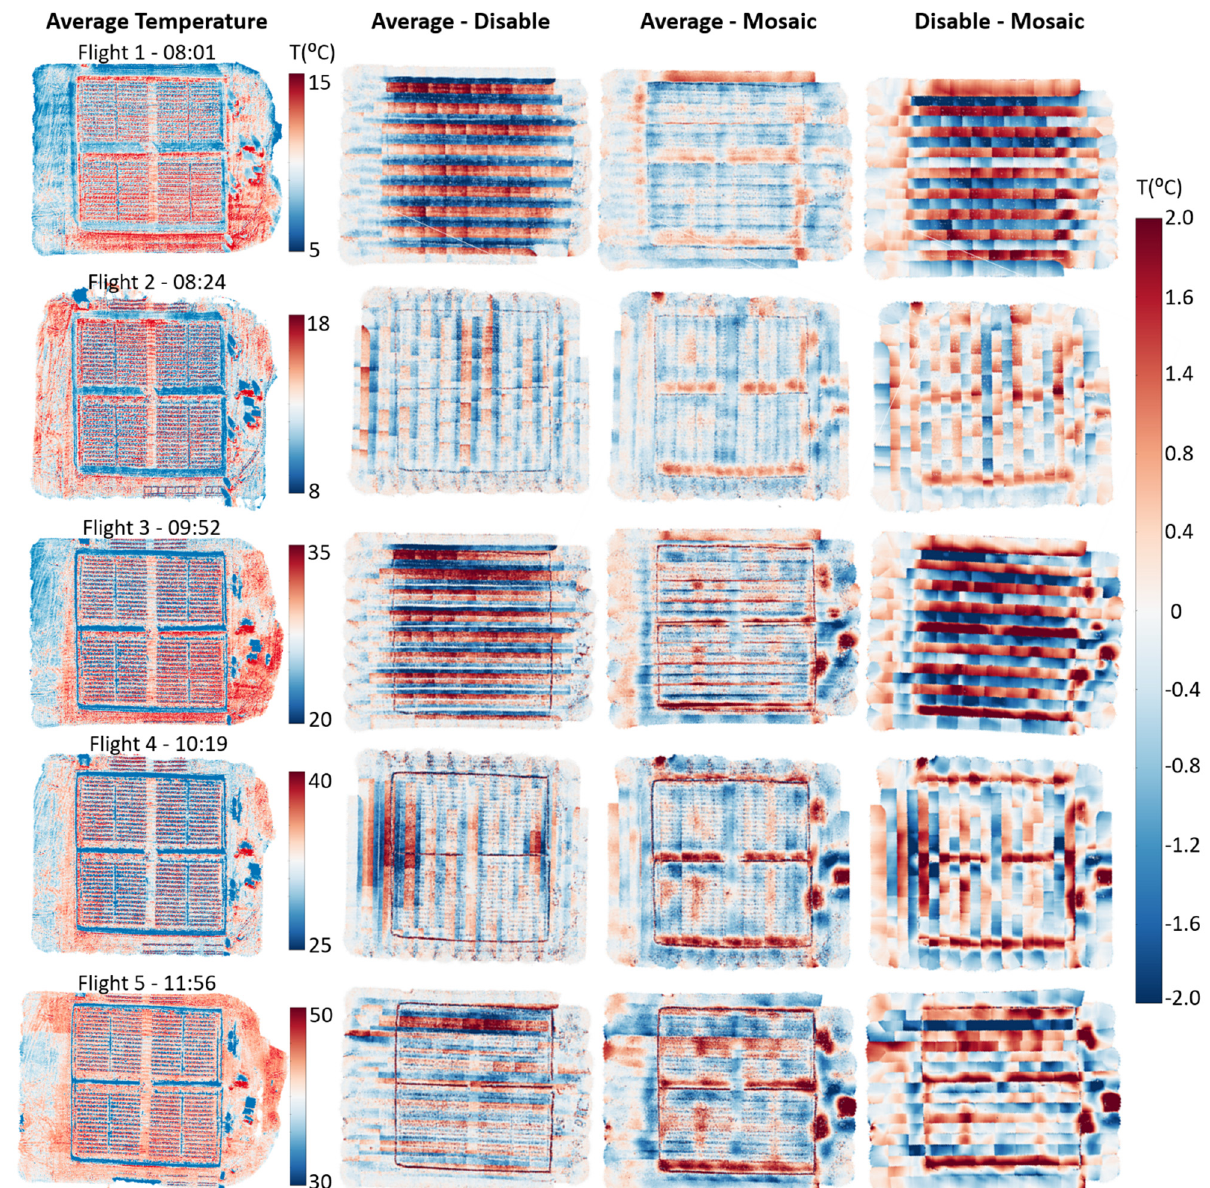
Figure 10. Maps showing temperature differences between orthomosaics produced using the Average , Disable and Mosaic blending modes from Agisoft PhotoScan based on calibrated orthophotos for five UAV flight surveys on 20 December 2017 at 08:01 (Flight 1), 08:24 (Flight 2), 09:52 (Flight 3), 10:19 (Flight 4) and 11:56 (Flight 5). As a reference, the first column shows the temperature orthomosaic based on the Average blending mode for each